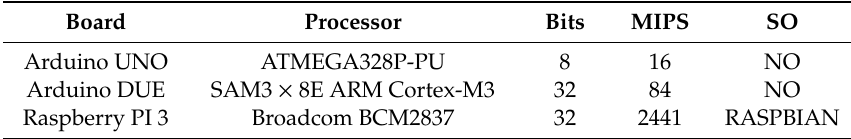
Table 3. Main characteristics of the three basic electronic boards used in this study.